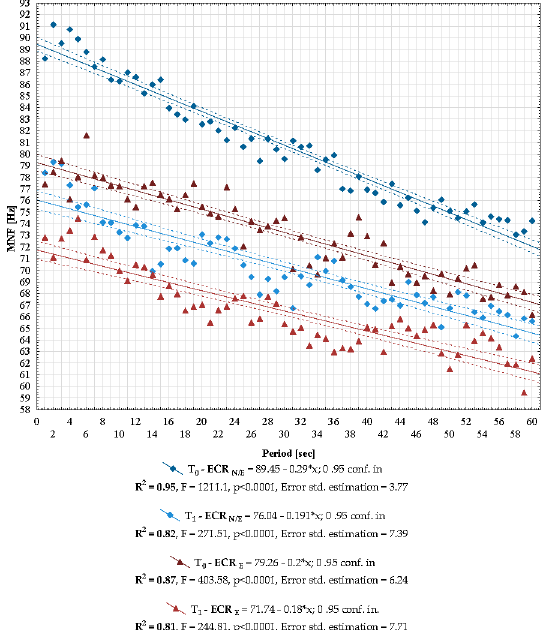
Figure 4. Change in the NF value recording during a 60 s fatigue isometric contraction. Legend: ECR—extensor carpi radialis longus and brevis muscles, LE —lateral enthesopathy, N/LE —healthy side, MNF—mean frequency.